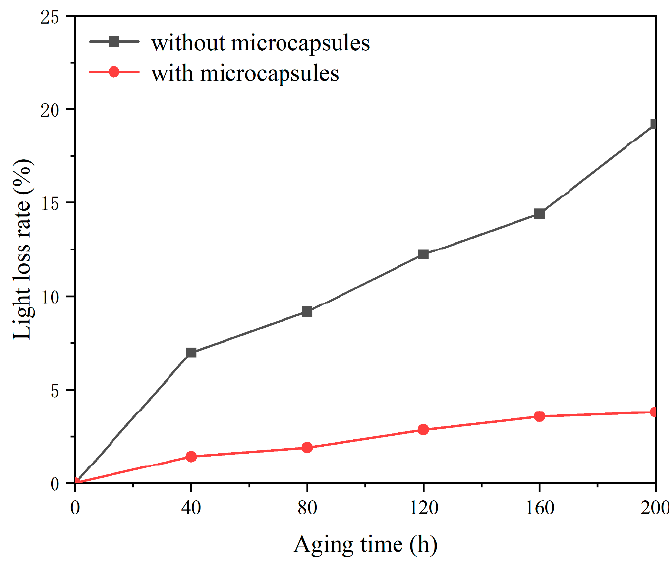
Figure 11. Effect of time on light loss rate of coating in UV weather resistance test.